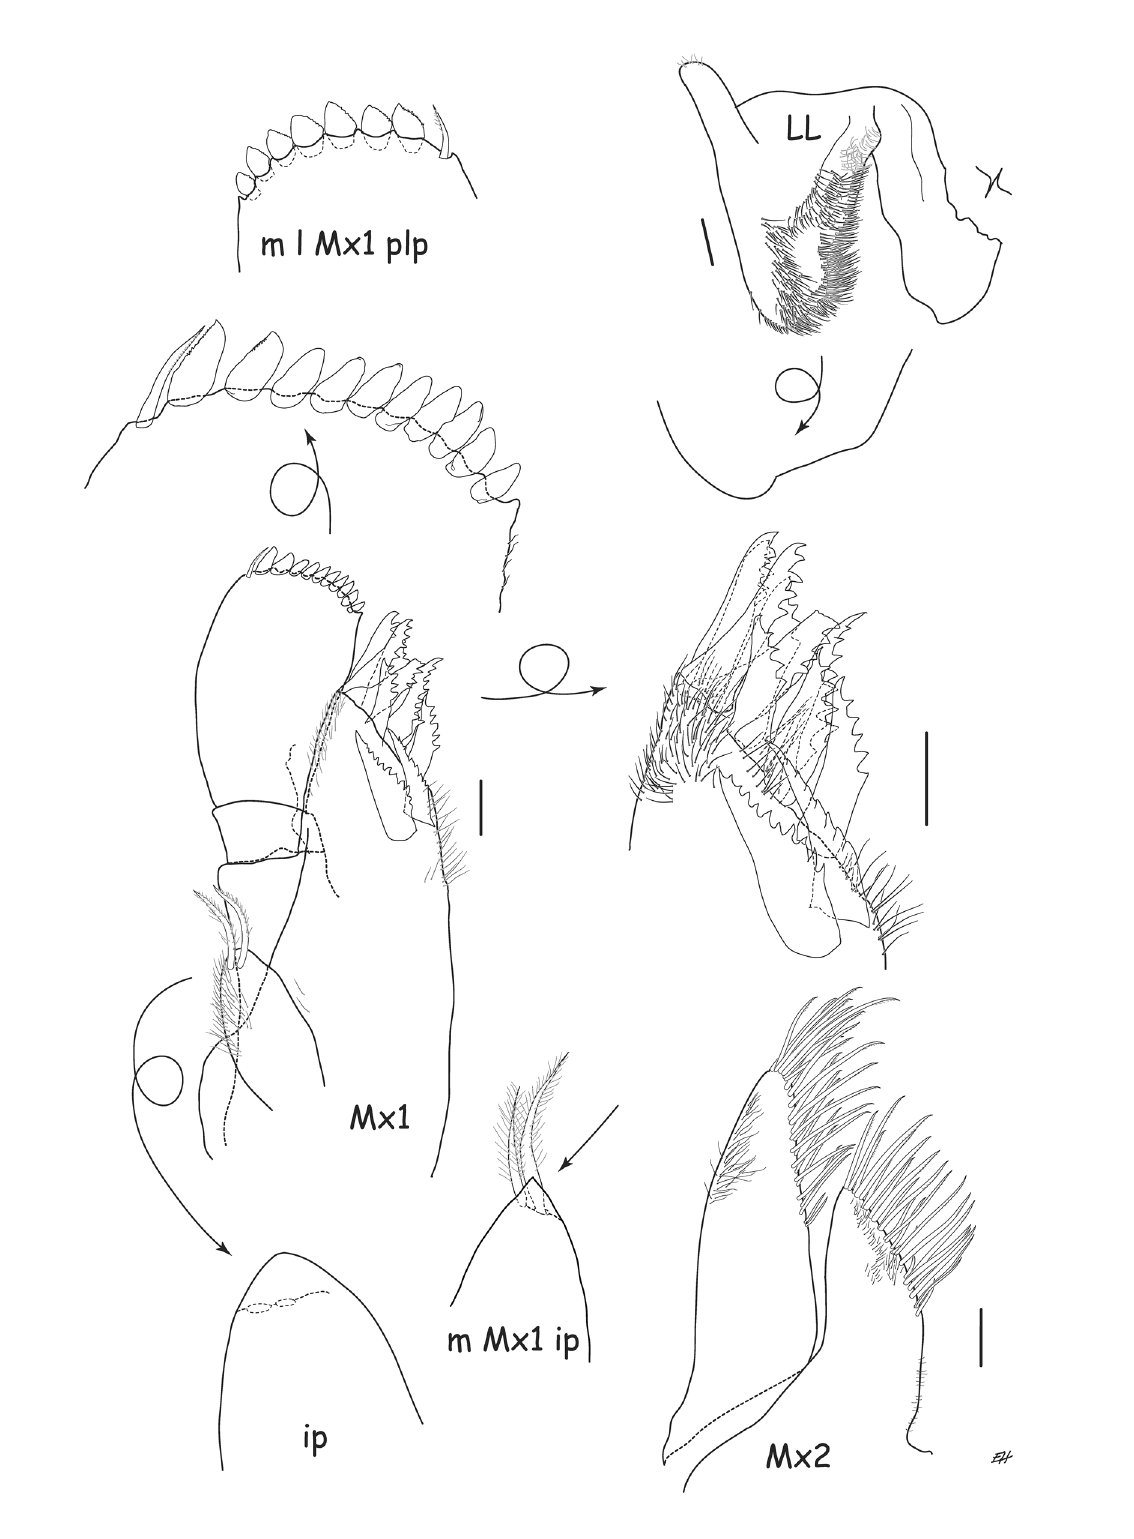
Fig. 28. Abyssorchomene shannonae sp. nov., holotype, ♀, 12 mm (ZMH K-61209); allotype, ♂, 7 mm (ZMH K-61210). LL partially broken. Figures with sex not indicated are of female. Scale bars = 0.1